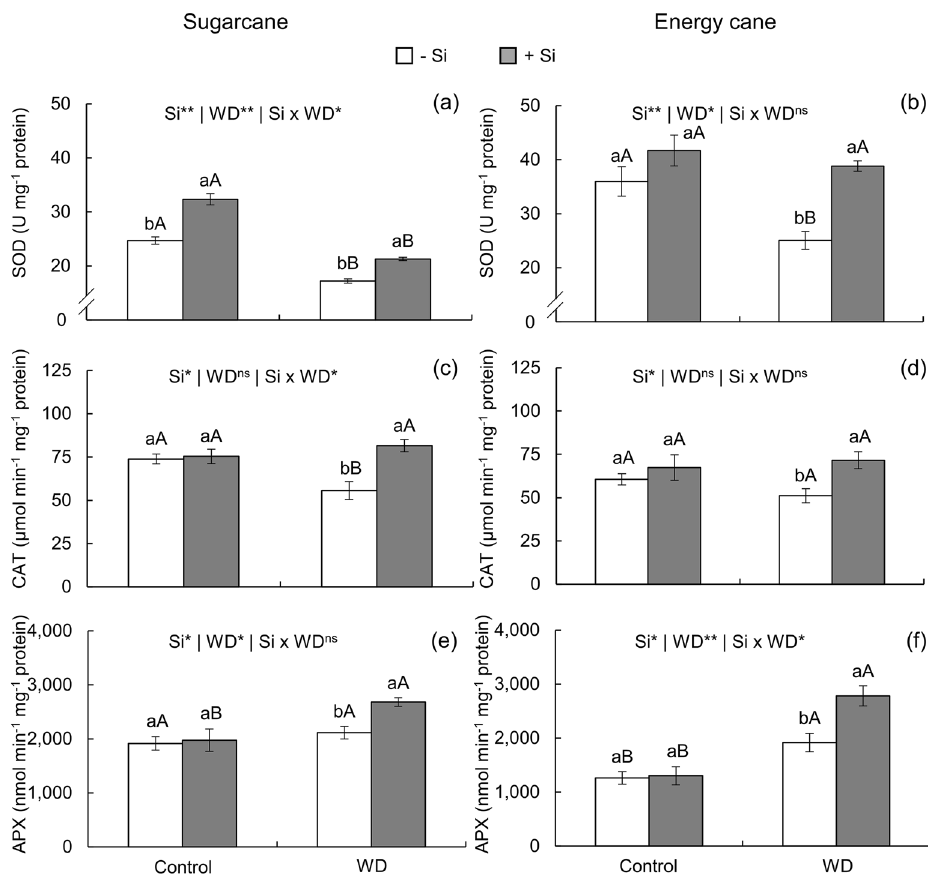
Figure 6. Specific activity of superoxide dismutase (SOD), catalase (CAT), and ascorbate peroxidase (APX) in sugarcane ( a , c , e ) and energy cane ( b , d , f ) in the absence of Si (-Si) and with Si applied via fertigation associated with foliar spraying (+ Si) under adequate water regime (control) and severe water deficit (WD) for a period of 7 to 160 days after transplanting. ** and * : significant at 1 and 5% probability, respectively; and ns : not significant by the F-test. Different lowercase letters indicate differences in relation to Si in the same water regime; different capital letters indicate differences in relation to the water regime in the same conditions of Si supply, both by the Tukey test. Bars represent the standard error of the mean; n =